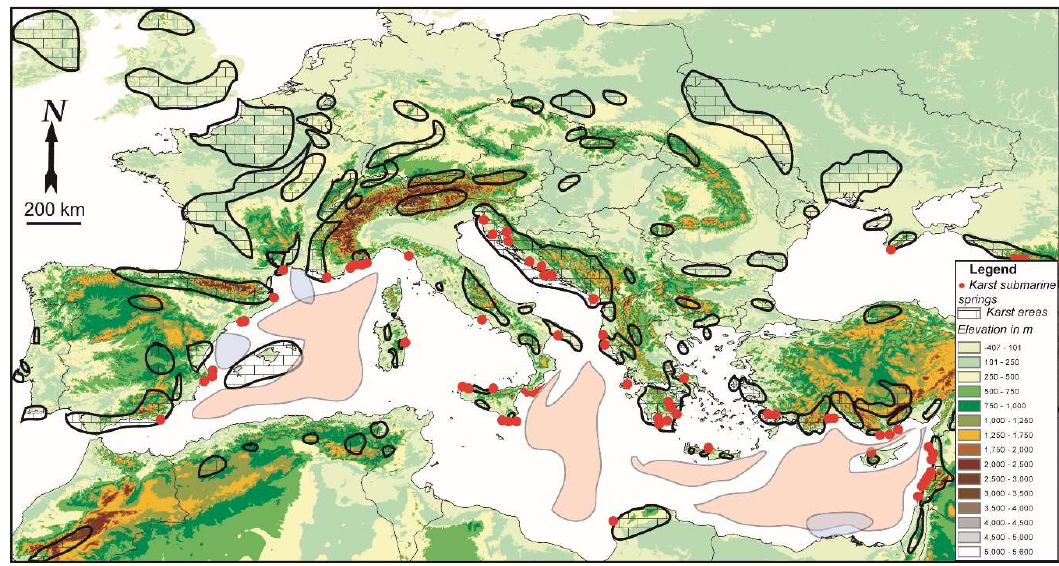
Figure 1. Schematic map of karst areas around the Mediterranean with the location of the main known karst submarine springs (adapted from [14]). The three main remaining hypersaline basins at the Messinian low stage are shown in pink with the main post-Messinian fluvial fans in grey (adapted from [15]).